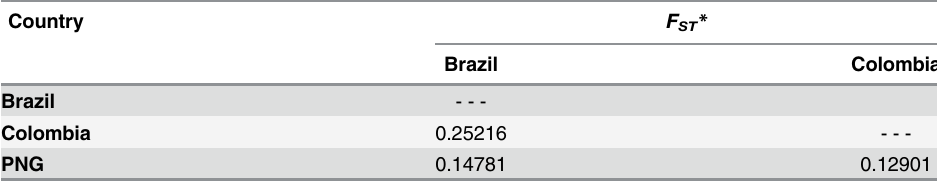
Table 4. Genetic distance ( F ST ) between Plasmodium falciparum populations from three analyzed countries.